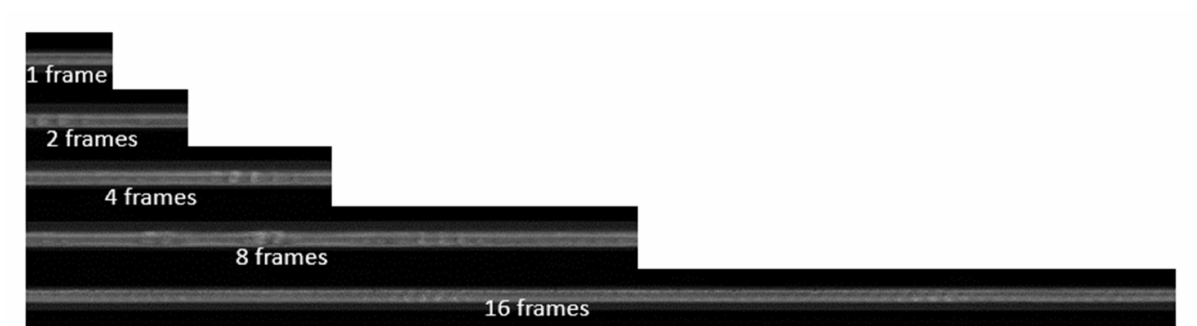
Figure 2. Block-diagram of the proposed method.